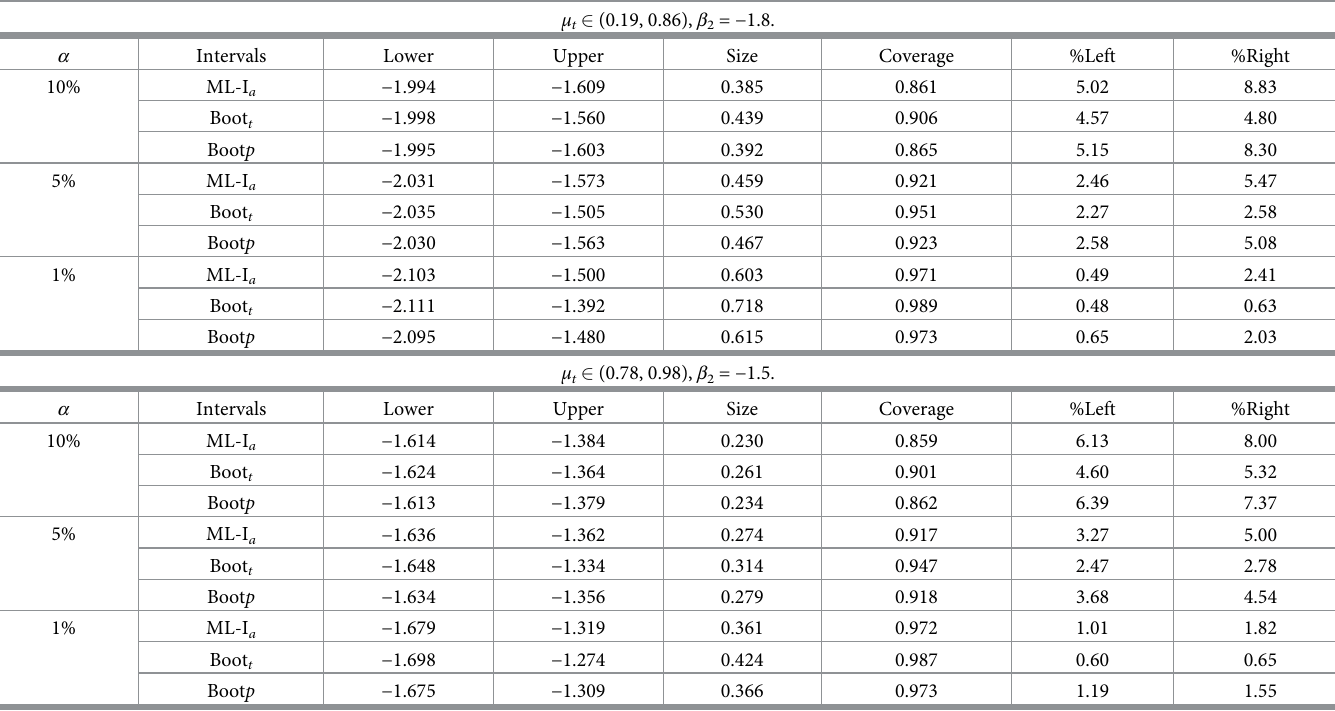
= 1 (cid:0) μ Þ ¼ β þ x β 2 þ β þ β and log ð σ 2 Þ ¼ γ þ z γ 2 , t = 1, ... , n , n = 40, λ � x x t t 2 t t 1 3 t 3 4 t 4 1 t